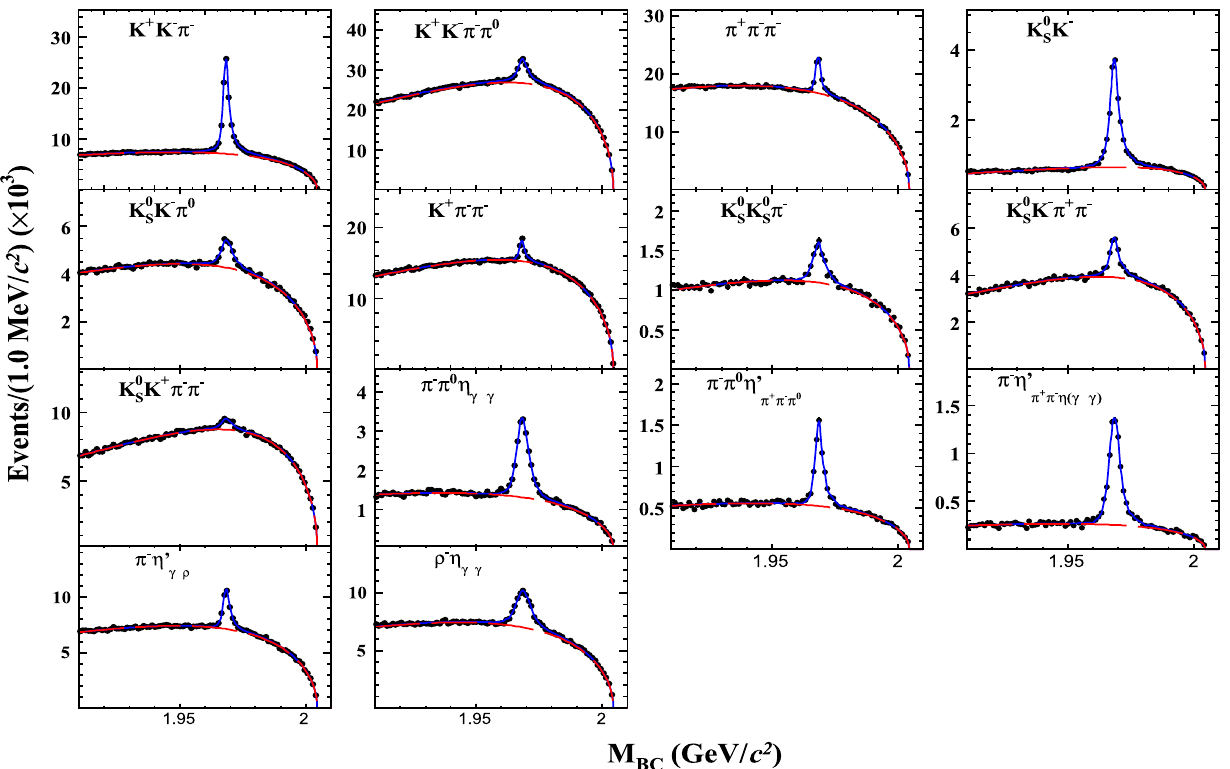
Fig. 1 Fits to the M BC distributions of D − s candidates, whose channels are single tag modes. The points with error bars are the pseudo-data. The blue curves are the fit results. The red curves are the fitted combinatorial